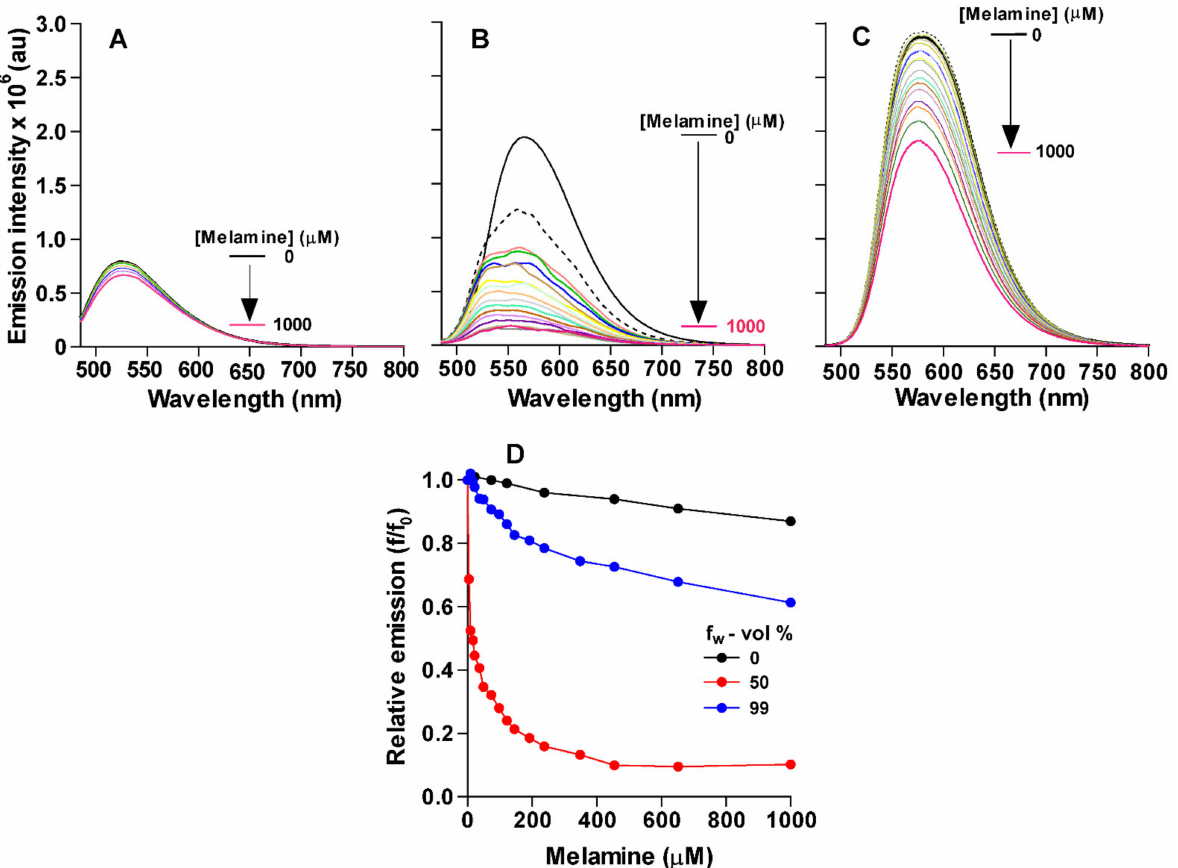
Figure 2. Titration of CB with melamine at varying w levels ( A ) f w 0%; ( B ) f w = 50% ( C ) f w 99%. ( D ) Plot showing the variation in relative emission of CB (f/f 0 ) with respect to melamine concentration (0–1000 µ M) for different f w (0, 50 and 100%) [f represents the total fluorescence emission of CB- aggregates at each melamine levels and f 0 is the total emission at zero -melamine